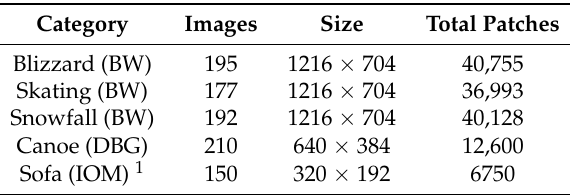
Table 3. Description of the complete dataset used to train our model. Columns represent the category of the images, the number of complete images used, the size of each image and the resultant number of 64 × 64 patches used to train the algorithm.